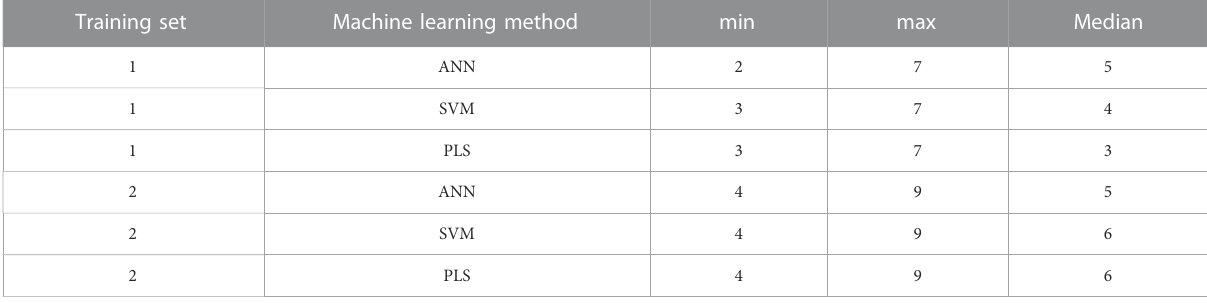
TABLE 3 The minimum, maximum and median number of the molecular descriptors in the fi nal predictor combinations for each training set and machine learning method. Training set